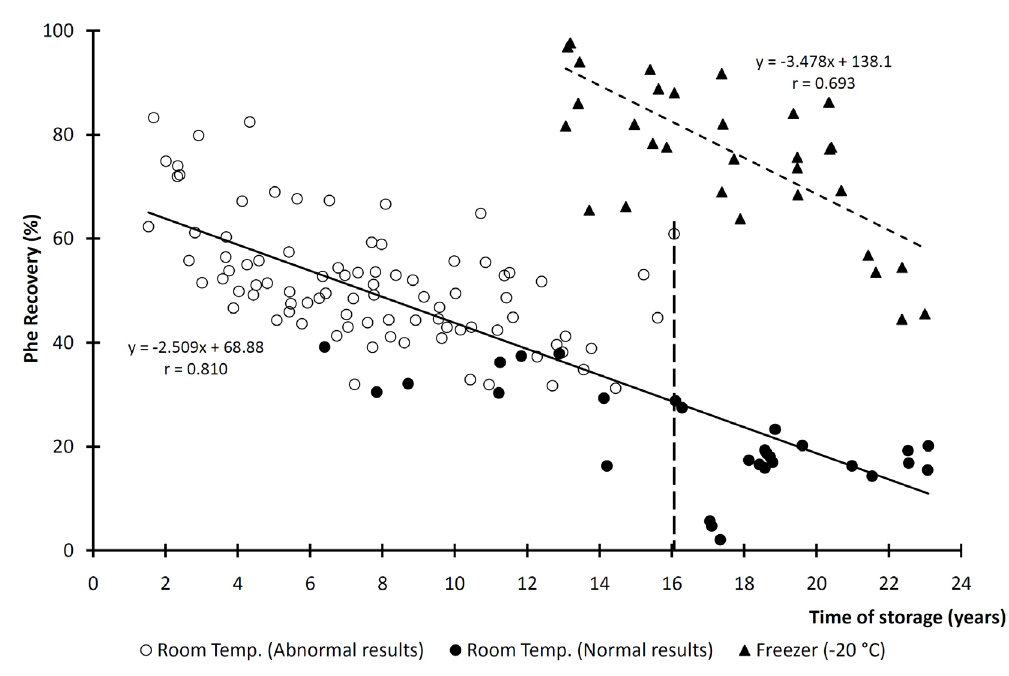
Figure 2. Phe recovery at retesting in residual DBS specimens stored in two different storage conditions. Note: the legend Abnormal/Normal results indicate the qualitative results interpretation at